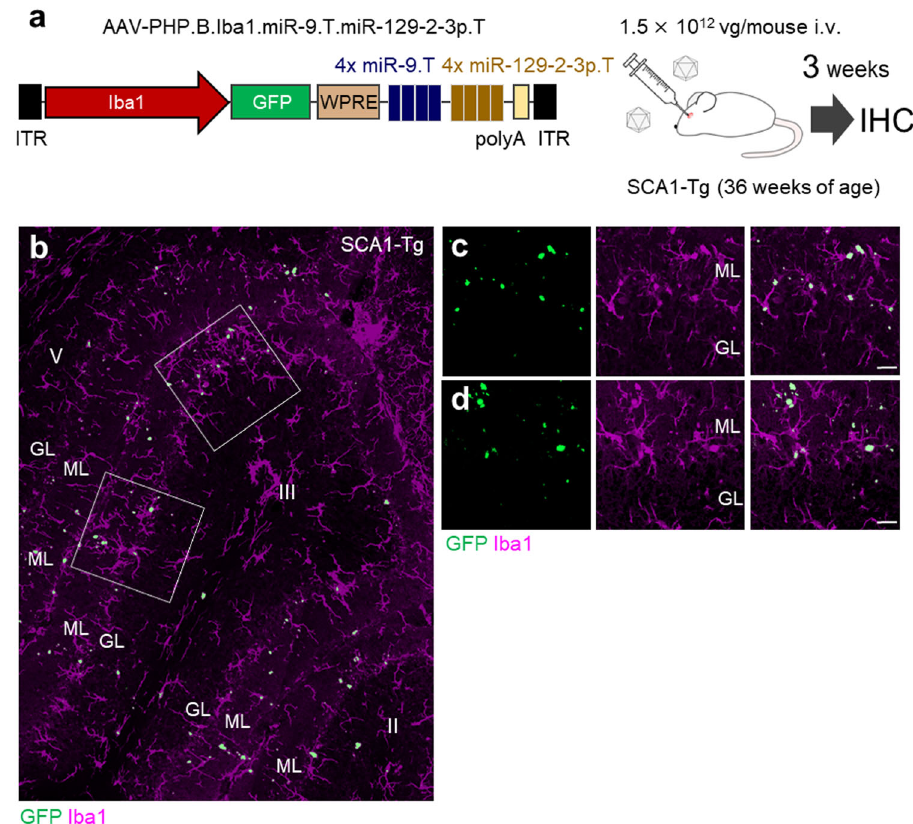
Fig. 8 Successful microglia targeting, but aggregate formation in SCA1-Tg mice by intravenous administration of AAV-PHP.B. a Diagram showing the AAV construct and experimental procedure. SCA1-Tg mice at 36 weeks of age received intravenous infusion of AAV-PHP.B.Iba1.miR-9.T.miR-129-2-3p.T (dose: 1.5 ×10 12 vg/mouse). Three weeks after the viral injection, brain sections were produced and analyzed by double immunolabeling for GFP and Iba1. ( b - d ) Immuno fl uorescent images of a sagittal section (lobules II and III) from the SCA1-Tg mouse ( b ) and the magni fi cation of square regions ( c , d ). Note aggregation of GFP in microglia in SCA1-Tg mouse cerebellum. Scale bars, 20 μ m. GL; granule cell layer, i.v.; intravenous injection, ML; molecular layer, SCA1-Tg; spinocerebellar ataxia type